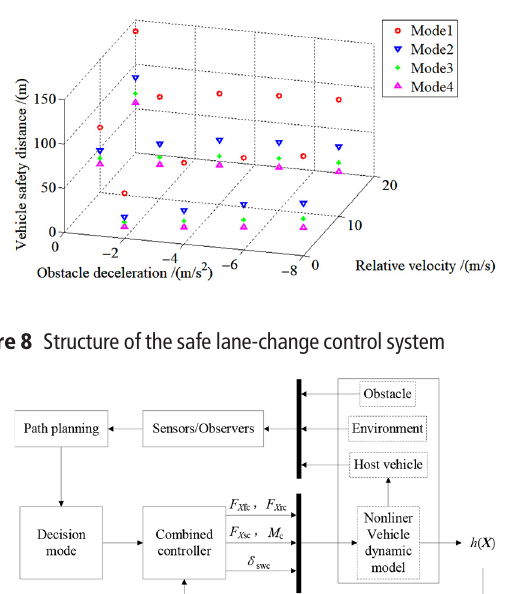
Figure 7 Vehicle safe distances in four-level lane changing modes